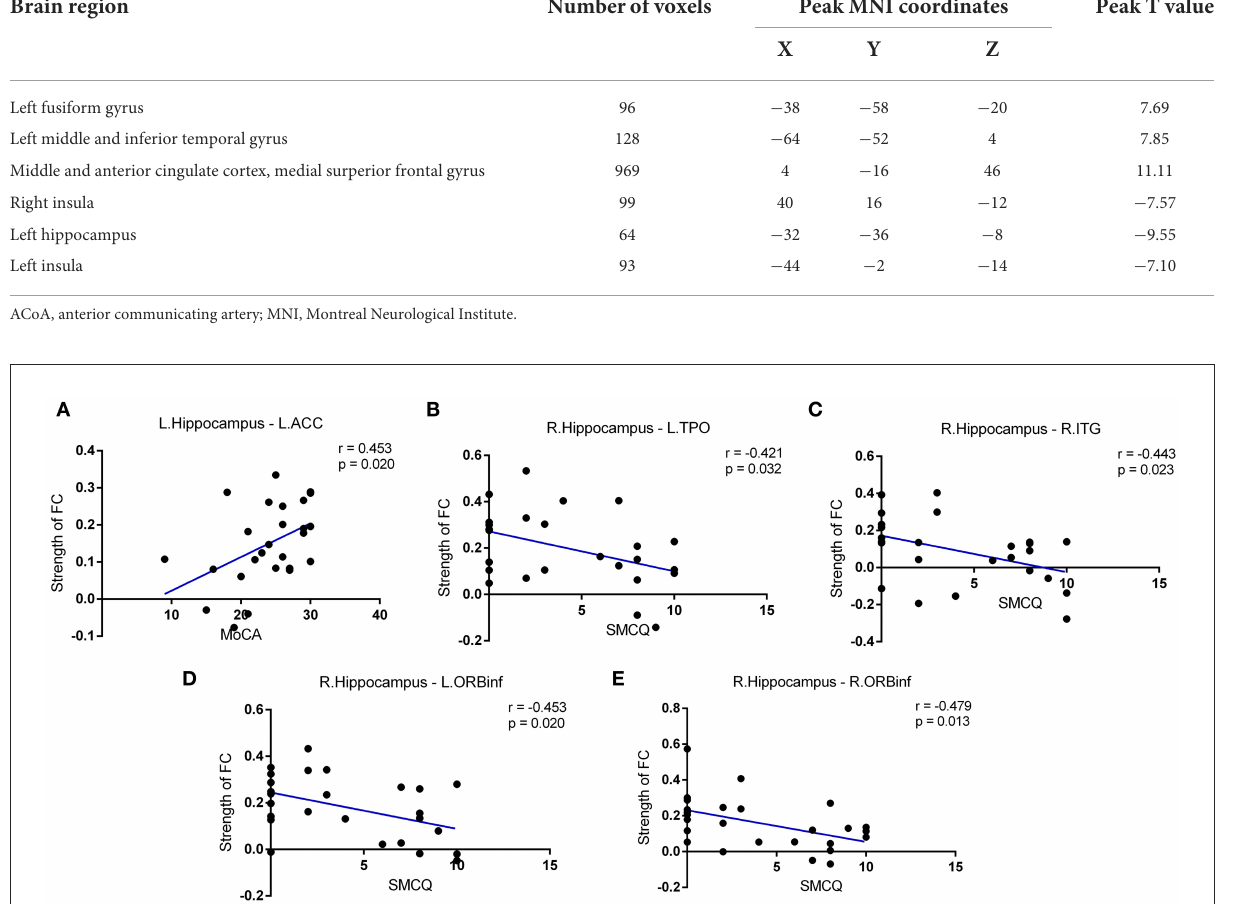
TABLE 3 Brain regions showing significant differences of the right hippocampus-based functional connectivity in patients with ruptured ACoA as compared to the healthy controls. Brain region Number of voxels Peak MNI coordinates